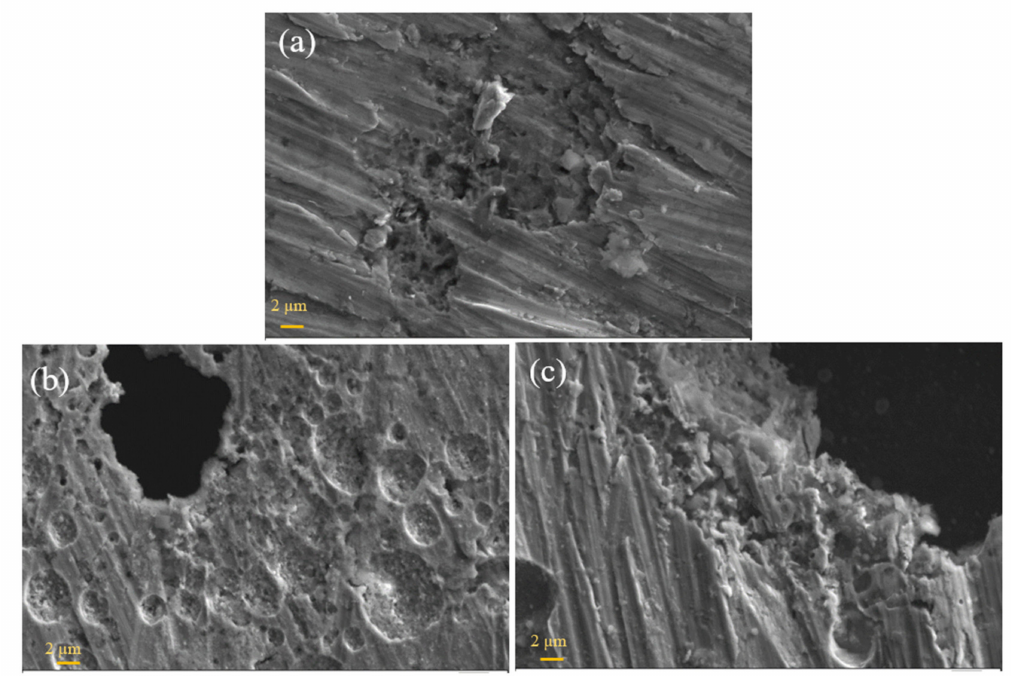
Figure 9. SEM images of the corroded surface for OPH1 heat treated for 20 h at 1000 ◦ C ( a ), 1100 ◦ C ( b ), and 1200 ◦ C ( c ) after the corrosion test (for all images: SE detector, EHT—15 kV, WD—approx. 9 mm).